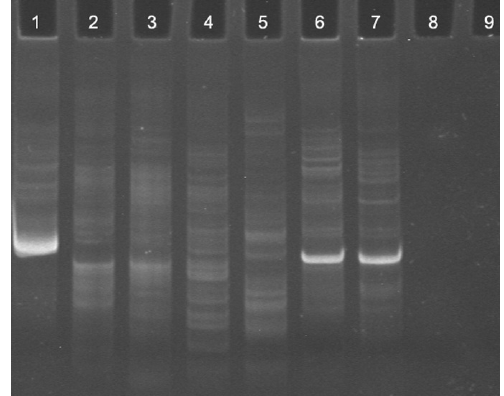
Figure 2 - Clonality analysis of a polyacrylamide gel following electro- phoresis of PCR products using the IgH Nizet protocol. Lane 1 : positive control; lanes 2, 3, 4 and 5 : polyclonal results (cases 2 and 4 in duplicate); lanes 6 and 7 : monoclonal results (case 13 in duplicate); and lanes 8 and 9 : undefined results (case 17 in